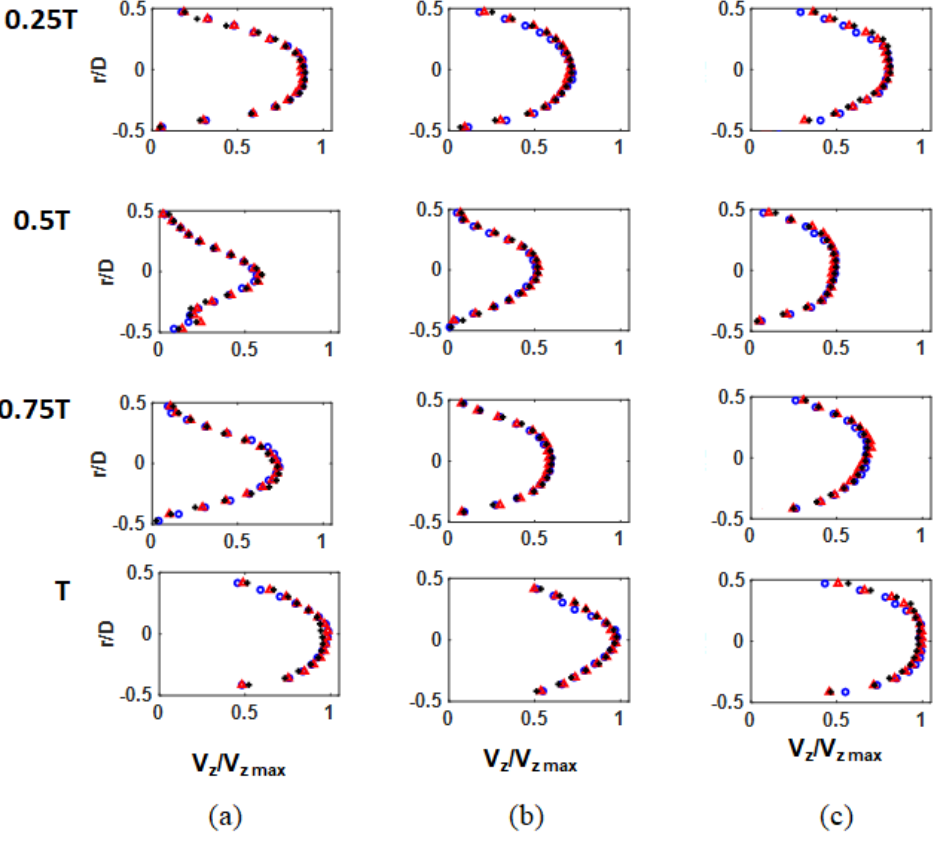
Figure 3: Upstream velocity profiles for (a) Re u =820, (b) Re u =1187 and (c) Re u =1625. Profiles are located at z 1 =-1.25D (blue circles), z 2 =-0.75D (red triangles) and z 3 =-0.25D (black plus